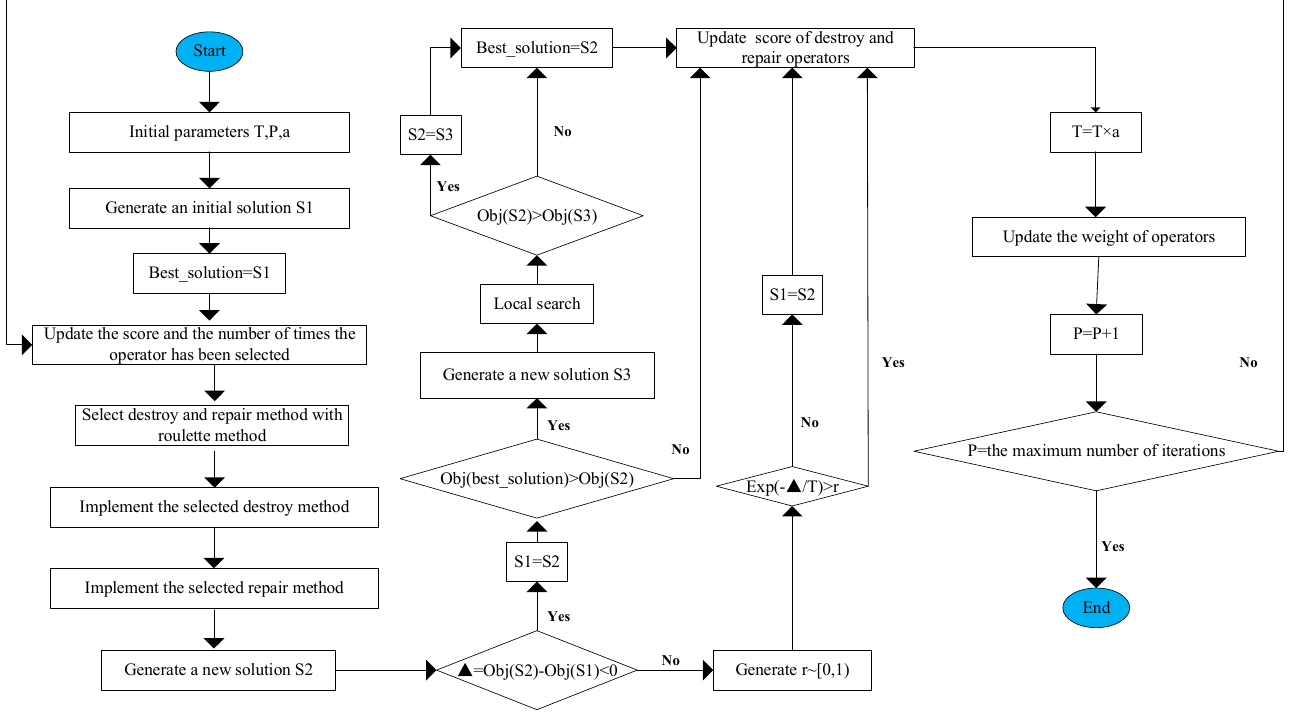
Figure 3. The flowchart of HALNS.